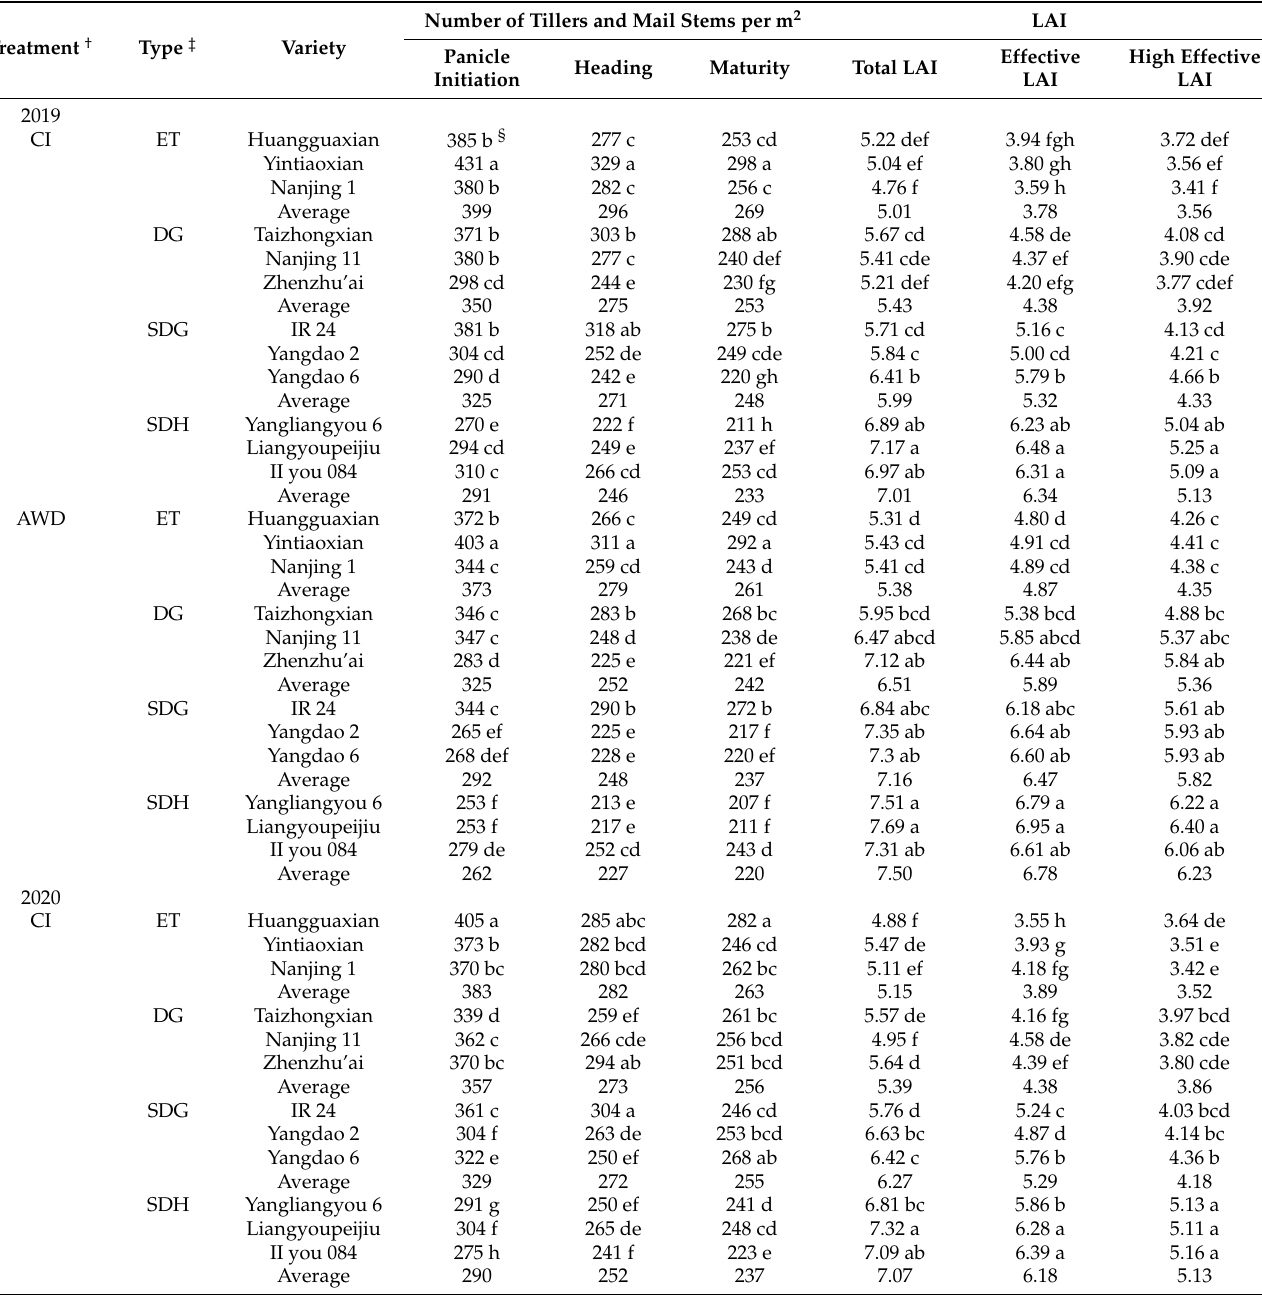
Table 5. Effect of irrigation on number of tillers and leaf area index at heading of mid-season indica rice genotypes during the in 2019 and 2020 growing